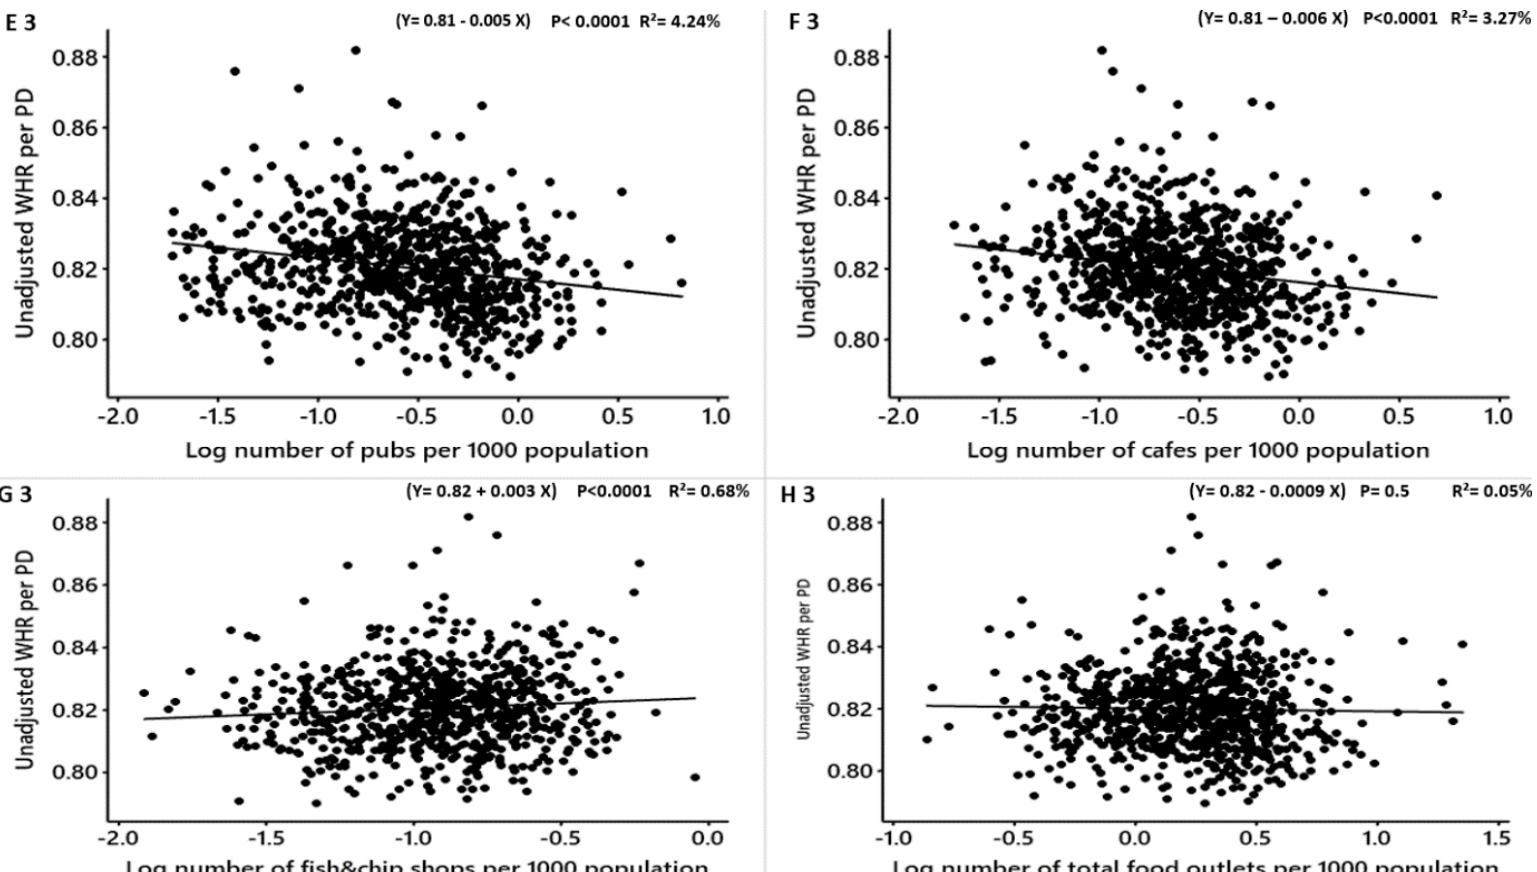
Figure 2. Females: Linear regression analysis of the association between log-transformed numbers of food outlets per 1000 population and unadjusted obesity measures. BMI = Body Mass Index, WHR = Waist to Hip Ratio. FFR = Fast-Food Restaurants, FSR = Full-Service Restaurants, total food outlets = combined.